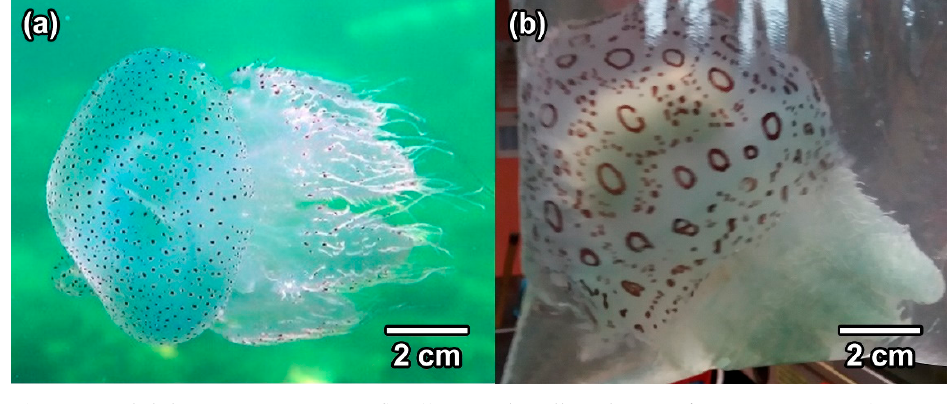
Figure 3. Solid dots on ( a ) Acromitus flagellatus and ocellate dots on ( b ) Acromitus maculosus . Characteristic features: The species while still alive is a vivid fuchsia colour, which darkens to a blood red upon death. A total of eight rhopalia [27] distributed about 82 marginal lappets (80–96 occurred in this species) [27] were counted in the specimen observed, along with eight oral arms, which had numerous thin pale filaments distributed throughout the tentacles. The exumbrella is smooth with no noticeable warts. The sting of the jellyfish is an uncomfortable burning sensation, irritating skin that is exposed to the mucus of the jellyfish. The species is clearly distinguished from its congeners from its colouration. C. mastigophora is the only member within genus Crambione that is red in colour, while all other species are beige or white